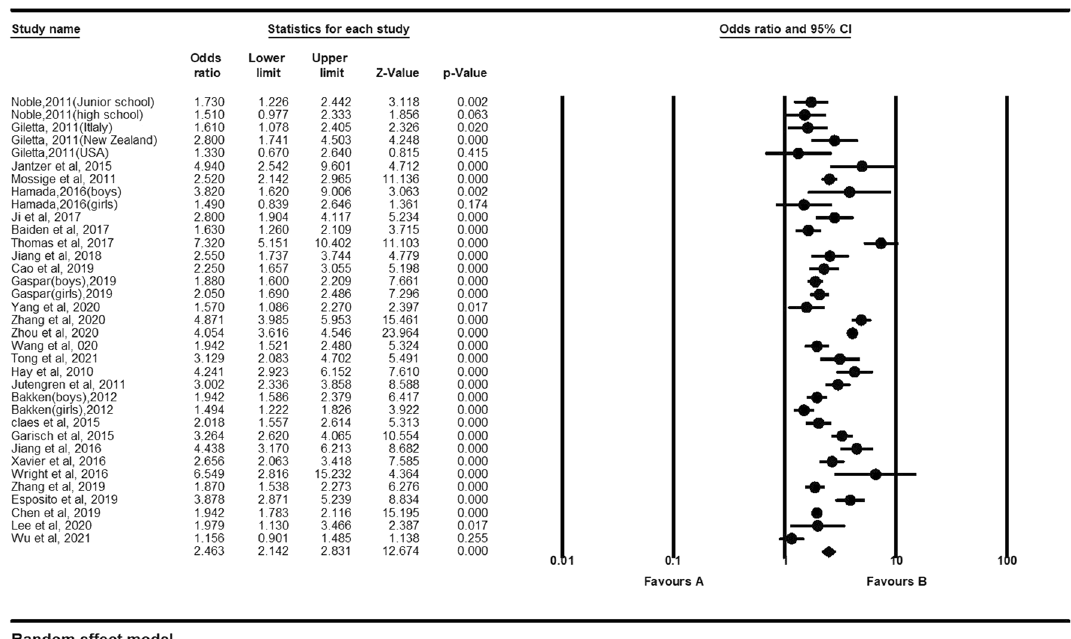
Figure 2. Forest plot for the effect size comparing the NSSI of victims with children not involved in bullying.